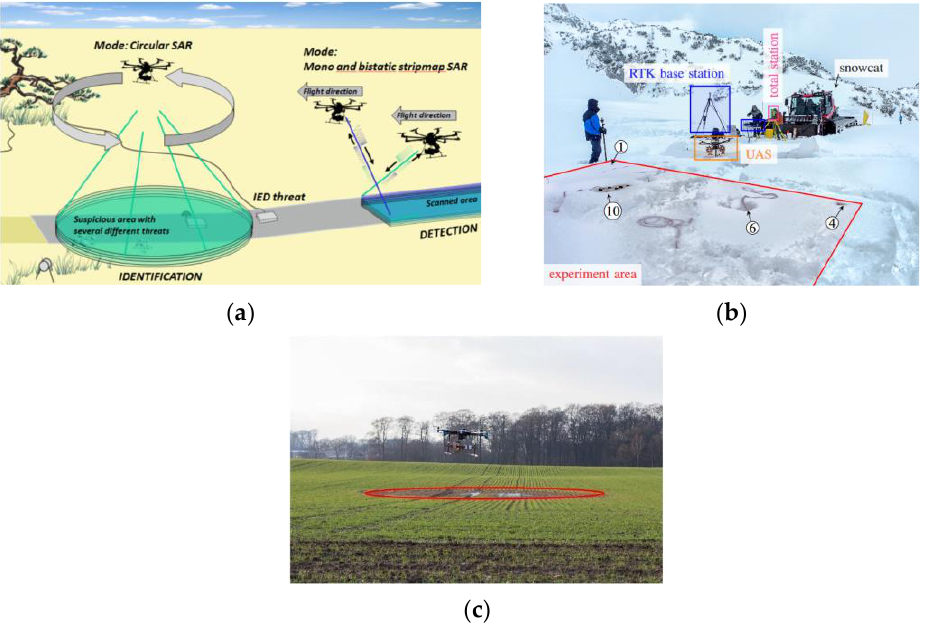
Figure 20. Examples of GPR applications: ( a ) Landmine detection (after [44]); ( b ) search and rescue (after [53]); ( c ) soil moisture (after [62]).